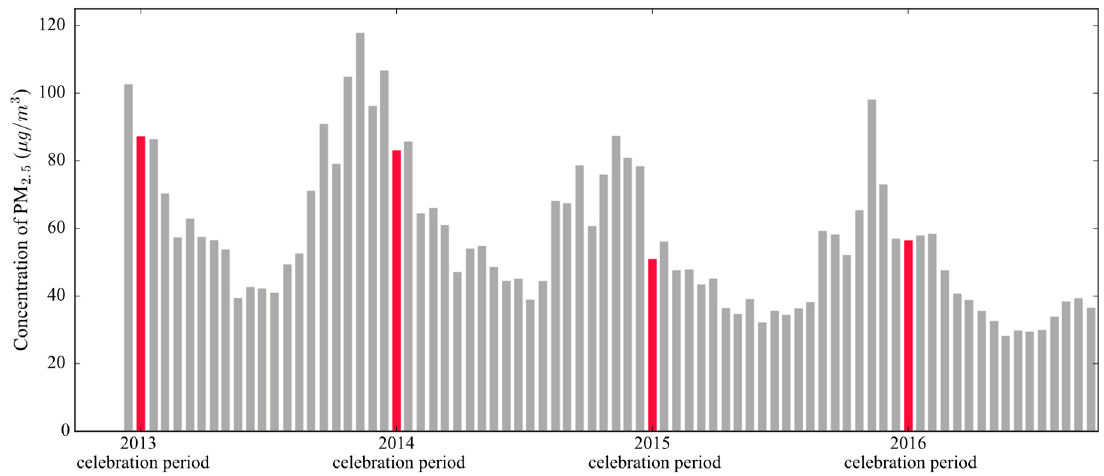
Figure 6. The 17-day averaged PM 2.5 concentrations from 2013 to 2016. The red bars represent the average PM 2.5 values during the four New Year celebration periods.